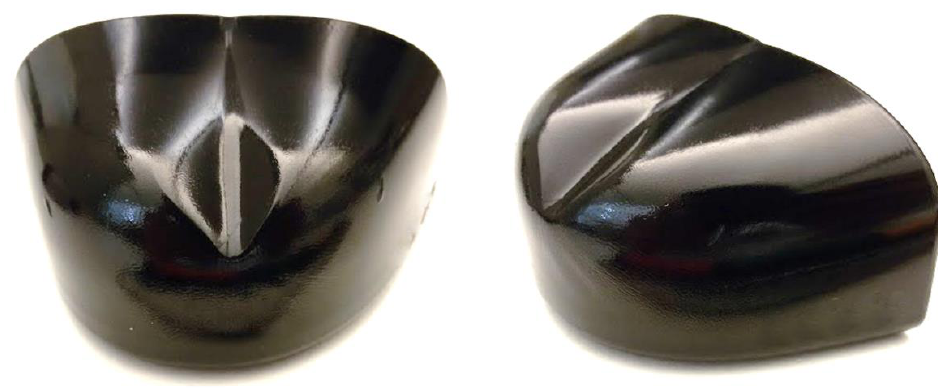
Figure 21. Geometry of a toe cap subjected to the impact